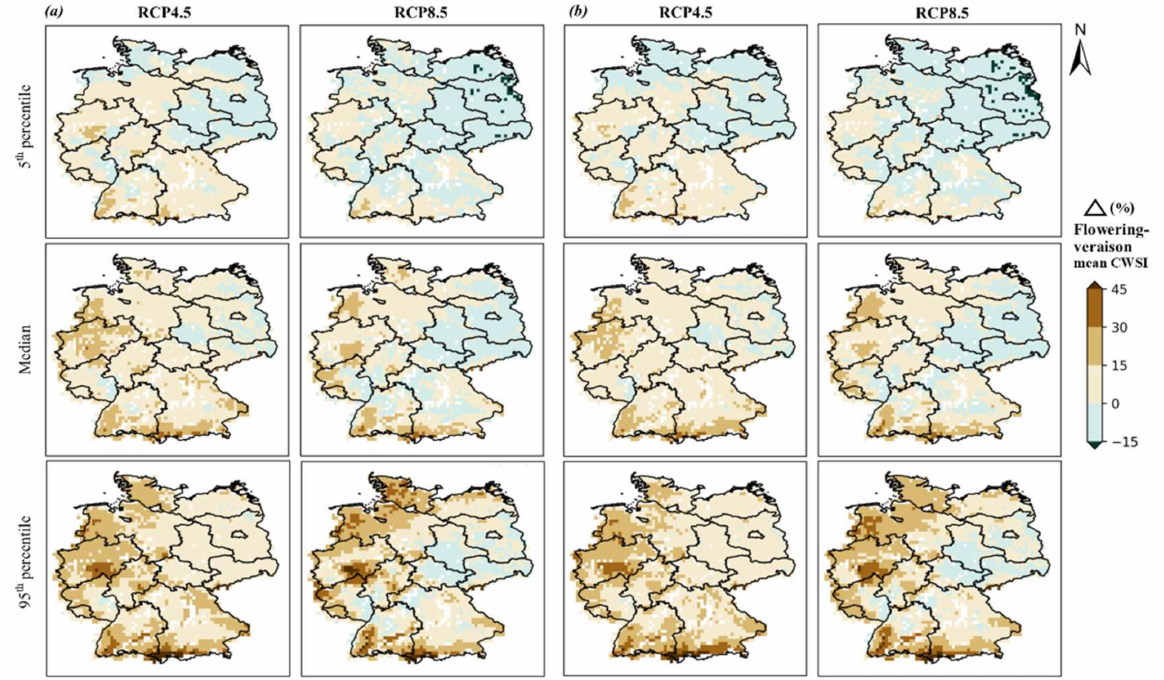
Figure 6. Projected changes (%) of mean crop water stress indicator (CWSI) for the flowering (BBCH65)-veraison (BBCH81) phenophase for ( a ) Müller-Thurgau and ( b ) Riesling between the future period (2041–2070) under RCP4.5 and RCP8.5 and the baseline period (1976–2005). The 5th percentile, median and 95th percentile of simulations under different climate models are shown. Positive values indicate increased CWSI (intensified water stress), whereas negative values denote respective reductions (alleviated water